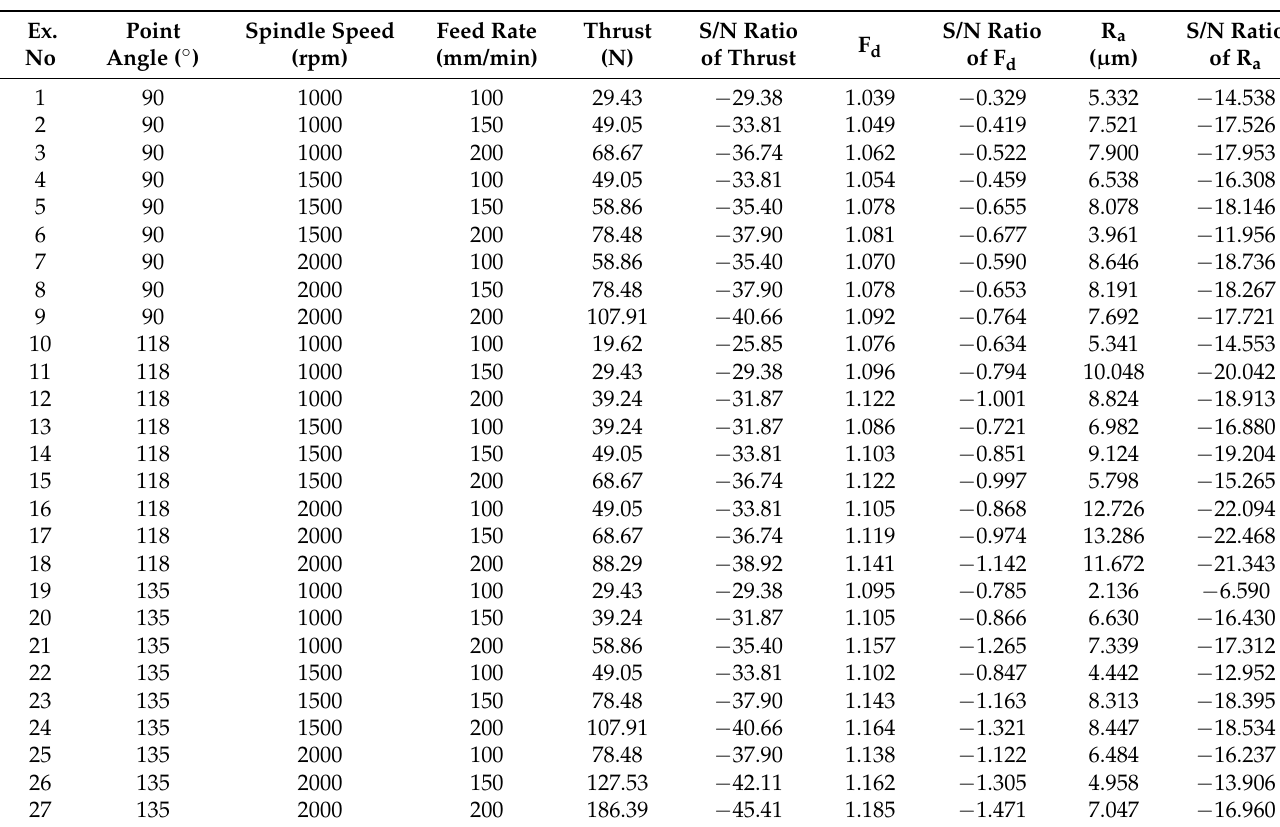
Table 3. Experiment